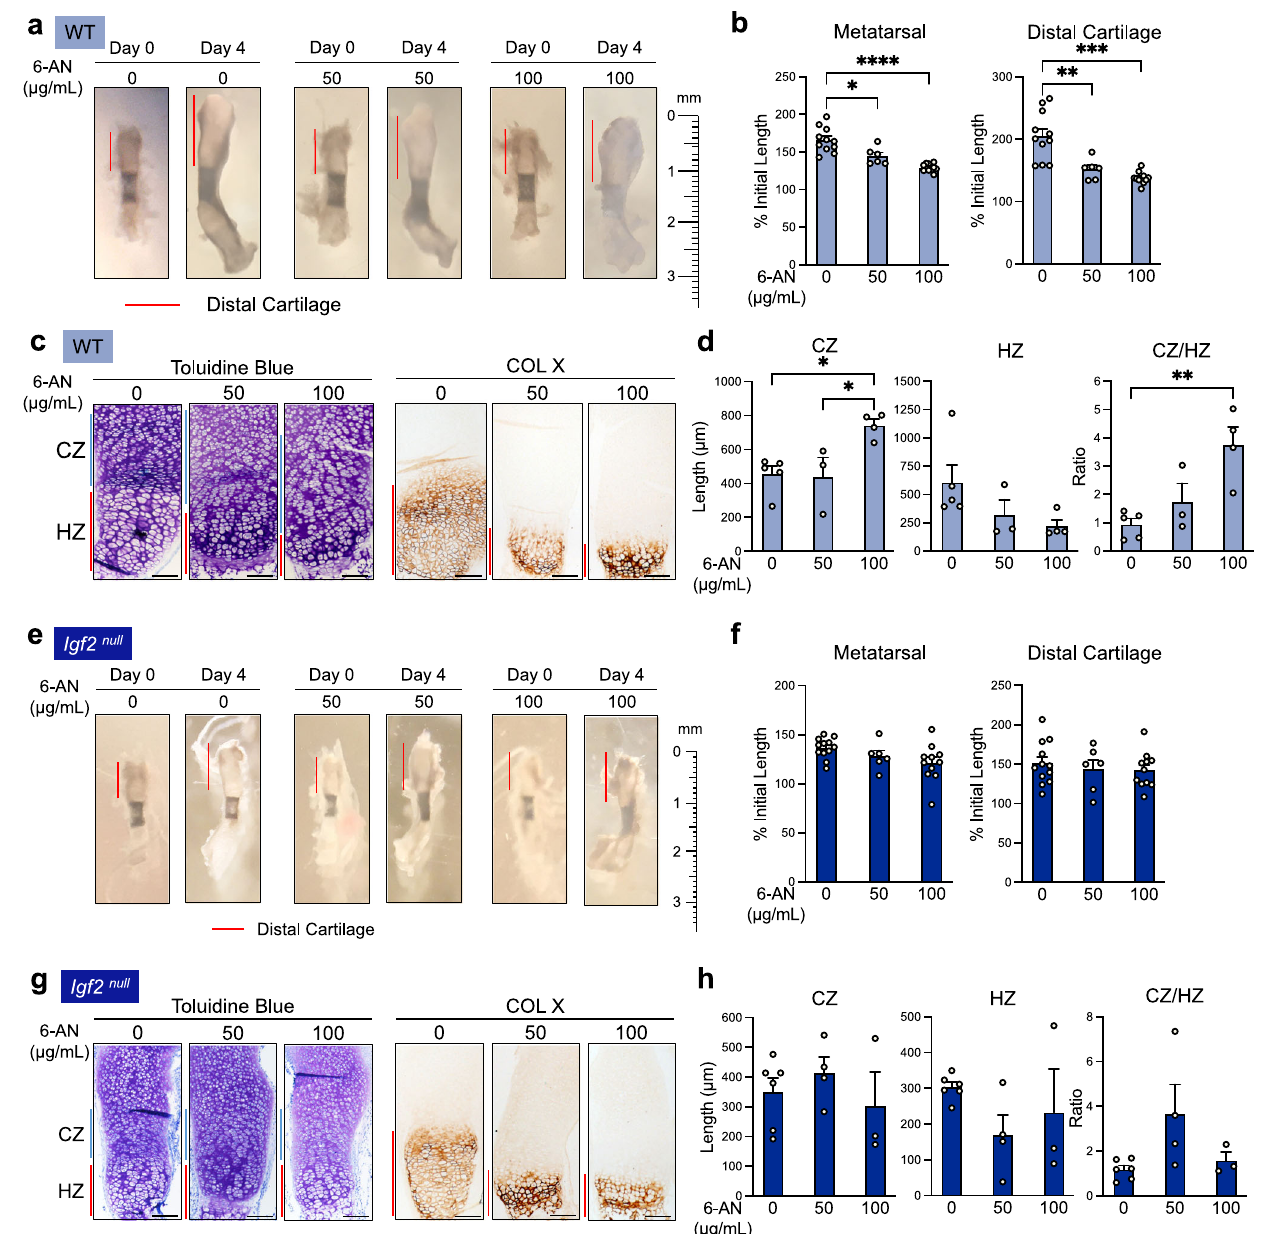
Fig. 7 The pentose phosphate pathway is required for proper hypertrophy and bone growth in ex vivo metatarsal culture. a WT metatarsal explants cultured for 4 days in the presence or absence of 6-AN. Representative of n = 6 – 11 bones per group. b Quanti fi cation of metatarsal and distal cartilage growth from the beginning of the culture period (as percent of initial length of metatarsal or distal cartilage). n = 6 – 11 bones per group. c Toluidine blue staining for morphology and IHC for collagen X (hypertrophic marker) in ex vivo-cultured WT metatarsals treated with 6-AN. Representative of n = 3 – 5 bones per group. CZ columnar zone. HZ hypertrophic zone. d Measurements of the lengths of the CZ and HZ, and the ratio of the CZ to HZ, in ex vivo- cultured metatarsals treated with 6-AN. e Igf2 null metatarsal explants cultured for 4 days with and without 6-AN. Representative of n = 6 – 12 bones per group. f Quanti fi cation of metatarsal and distal cartilage growth from the beginning of the culture period (as percent of initial length of metatarsal or distal cartilage). n = 6 – 12 bones per group. g Toluidine blue staining for morphology and IHC for collagen X in Igf2 null metatarsals treated with 6-AN. Representative of n = 3 – 6 bones per group. h Measurements of the lengths of the CZ and HZ, and the ratio of the CZ to HZ, in Igf2 null metatarsals treated with 6-AN. n = 3 – 6 bones per group. Scale bar: 100 µ m. Data are presented as individual measurements with mean + SEM. Note that the control data (0 µ g/mL 6-AN) for b , d , f , and h are also shown in Fig. 5. Statistical signi fi cance was calculated by Brown – Forsythe and Welch ANOVAs with Dunnett ’ s T3 test for multiple comparisons ( b ) or one-way ANOVA with Tukey ’ s test for multiple comparisons ( d , f , h ). p -values indicated as * p < 0.05, ** p <